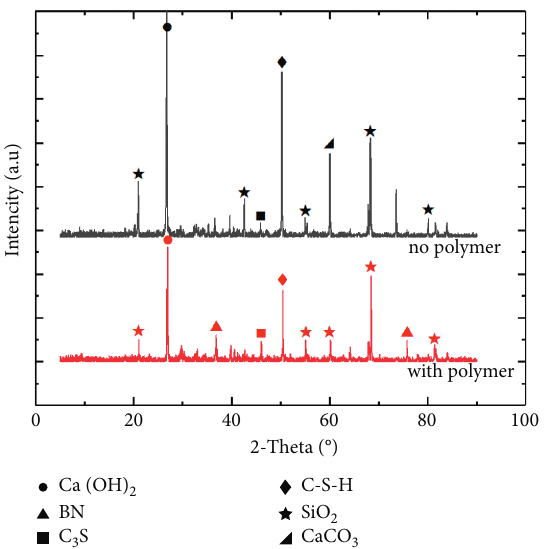
Figure 10: X-ray diffraction pattern without polyurethane and with polyurethane (P5).